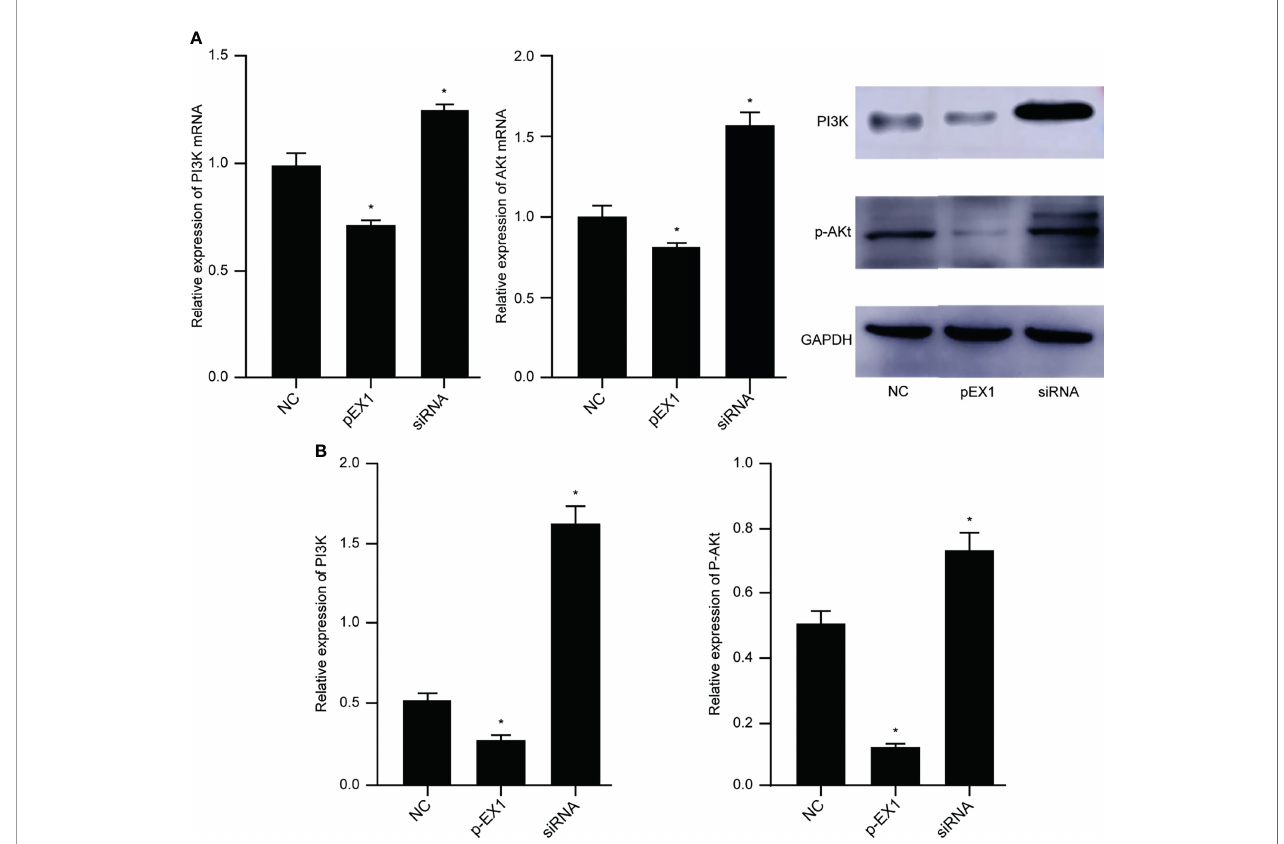
FIGURE 5 | PI3K/AKT signaling pathway in macrophages of each group. (A) Expression of PI3K and AKT genes in macrophages of each group; (B) PI3K and p- AKT protein levels in macrophages of each group. (siRNA group: S2 sequence). * p < 0.05 compared to the NC